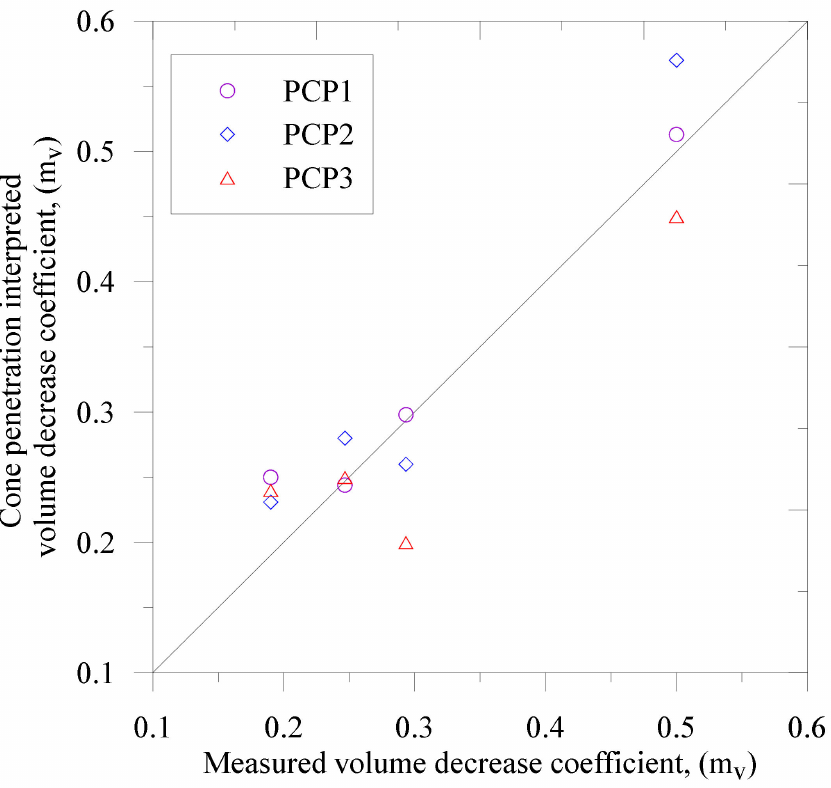
Figure 14. Relationship of the measured and predicted volume decrease